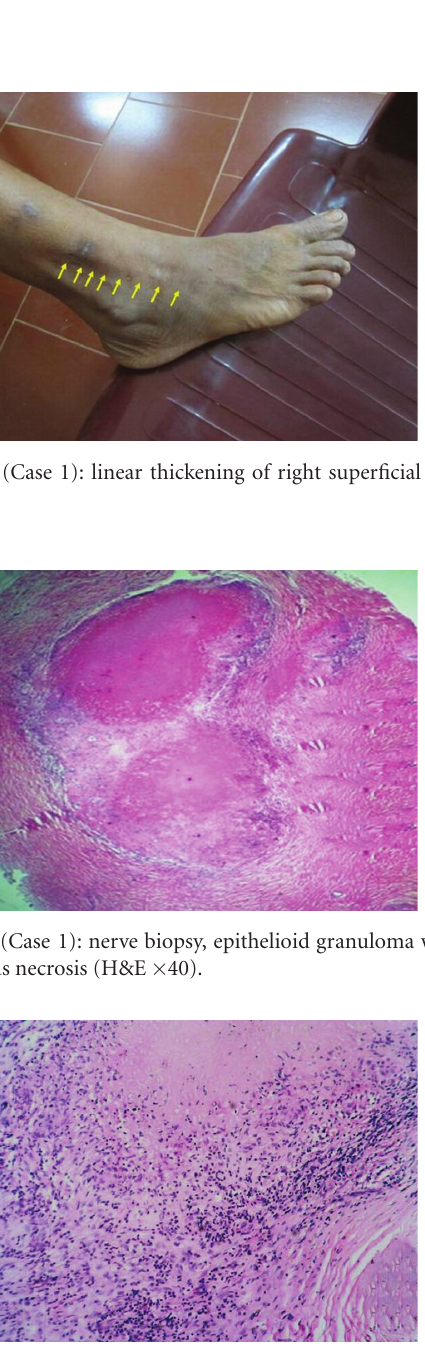
Figure 3: (Case 1): higher power view of Figure 2: Necrosis, Epithe- lioid cells and Lymphocytes seen (H&E × 100).